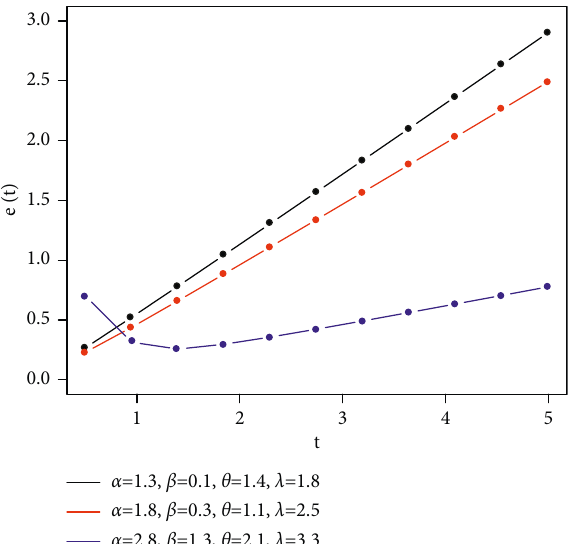
Figure 3: Mean excess function plots for some sets of parameter values.